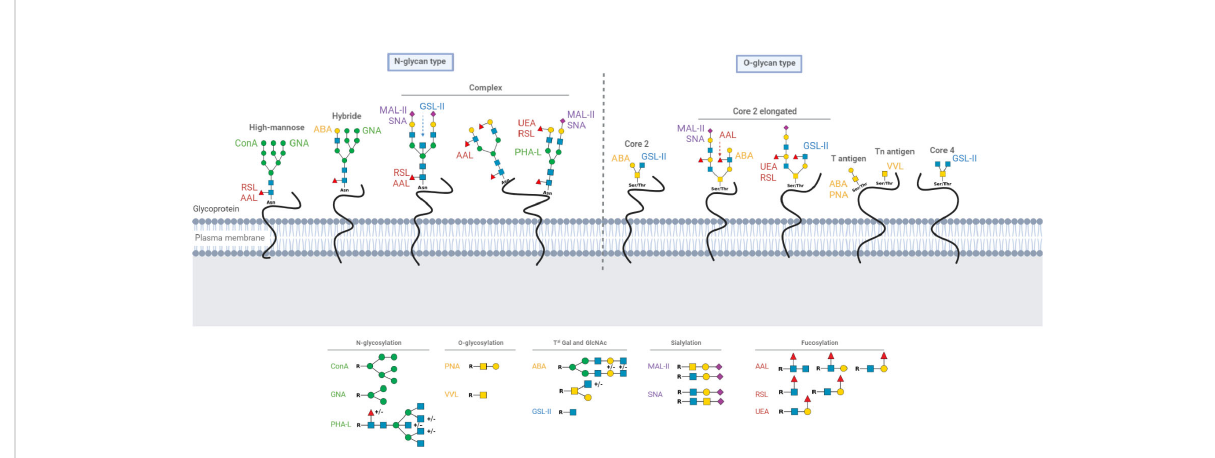
FIGURE 1 Schematic representation of N and O-glycoproteins on cell surface and glycan motives recognized by lectins.The different known forms of N and O-glycoproteins on cell surface are presented as well as glycan motives recognized by lectins. Green circle: Mannose; yellow circle: Galactose; yellow square: N-acetylgalactosamine; blue square: N-acetylglucosamine; purple diamond; Sialic acid and red triangle; Fucose. Asn, Asparagine; Thr, Threonine; Ser,